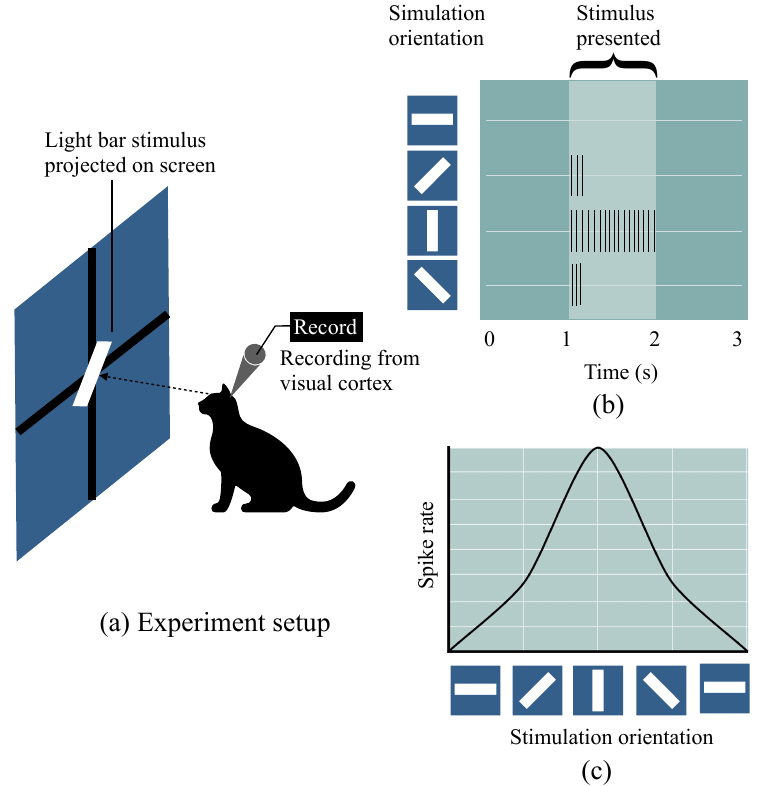
Figure 1. A neuron in the primary visual cortex responds selectively to line segments. ( a ) An anesthetized cat is fitted with contact lenses to focus the eyes on a screen, then project images on screen and record neuron responses by an extracellular electrode. ( b ) The neuron recorded in the primary visual cortex typically responds vigorously to a bar of light oriented at a particular orientation angle and with little or no response to other orientations. ( c ) The curve of neuron spike rate with the stimulation orientation